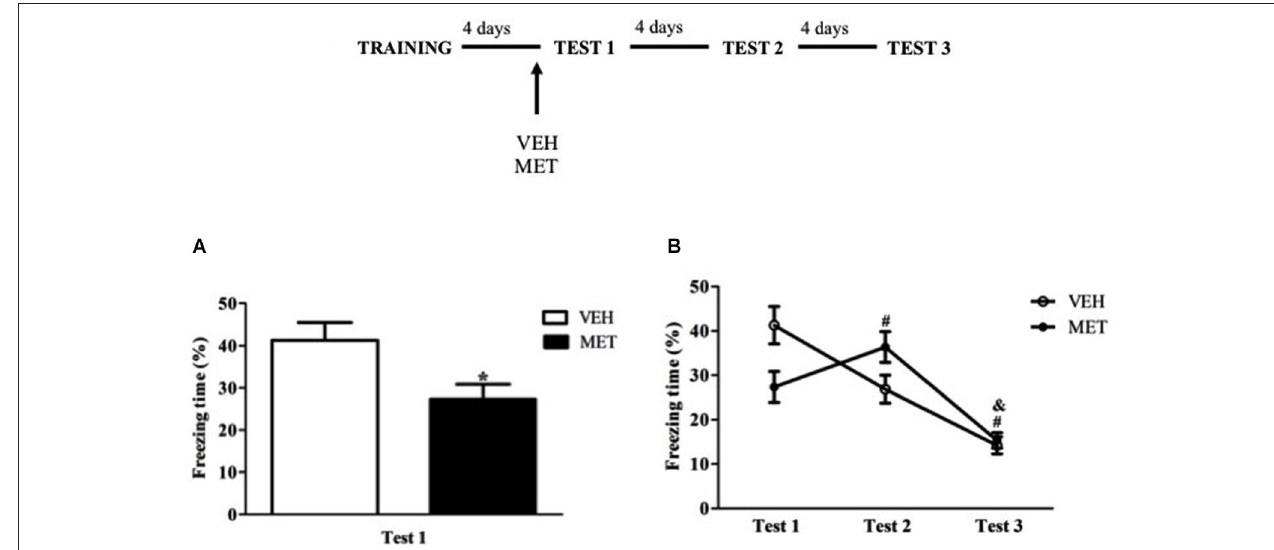
FIGURE 1 | Acute metyrapone treatment reduced freezing behavior on Test 1 . (A) Metyrapone significantly reduced freezing on Test 1. (B) Metyrapone reduced freezing on Test 1 and this effect did not persist